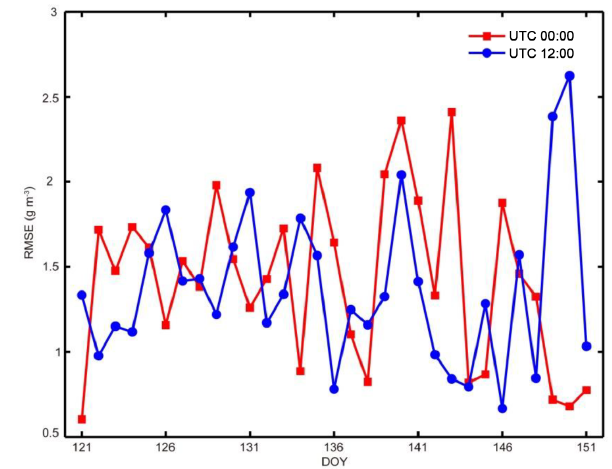
all RS sampling points of the RS profile below 10800m at tomo- graphic epochs 00:00 and 12:00UTC on each day of the month (DOYs